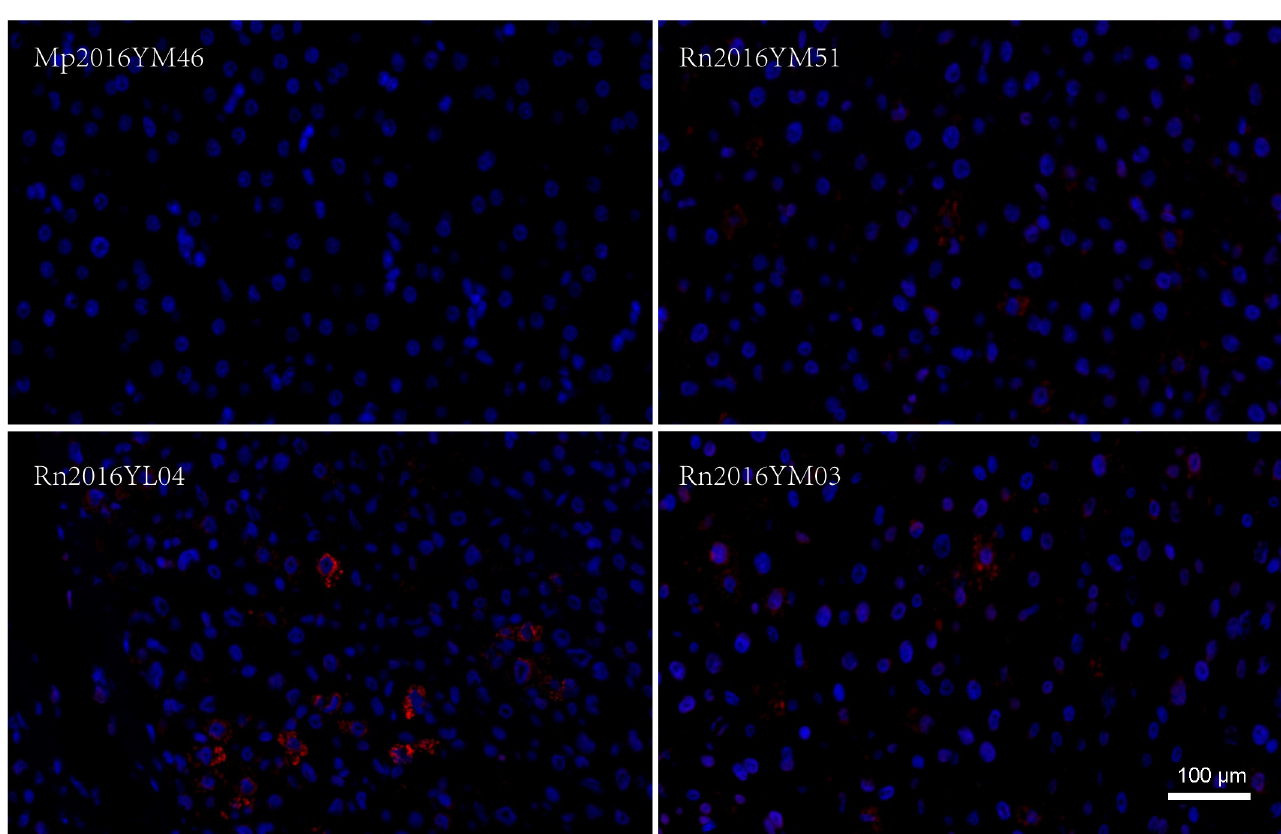
Fig 6. Viral protein detection by indirect immunofluorescence in liver sections. The red color showed the presence of viral NP. The blue nucleus was stained by 4 0 , 6-diamidino-2-phenylindole (DAPI). Three WENV positive liver samples (Rn2016YM51, Rn2016YL04, and Rn2016YM03) and one negative (Mp2016YM46) sample were selected for testing by indirect immunofluorescence. Bar represents 100 μ